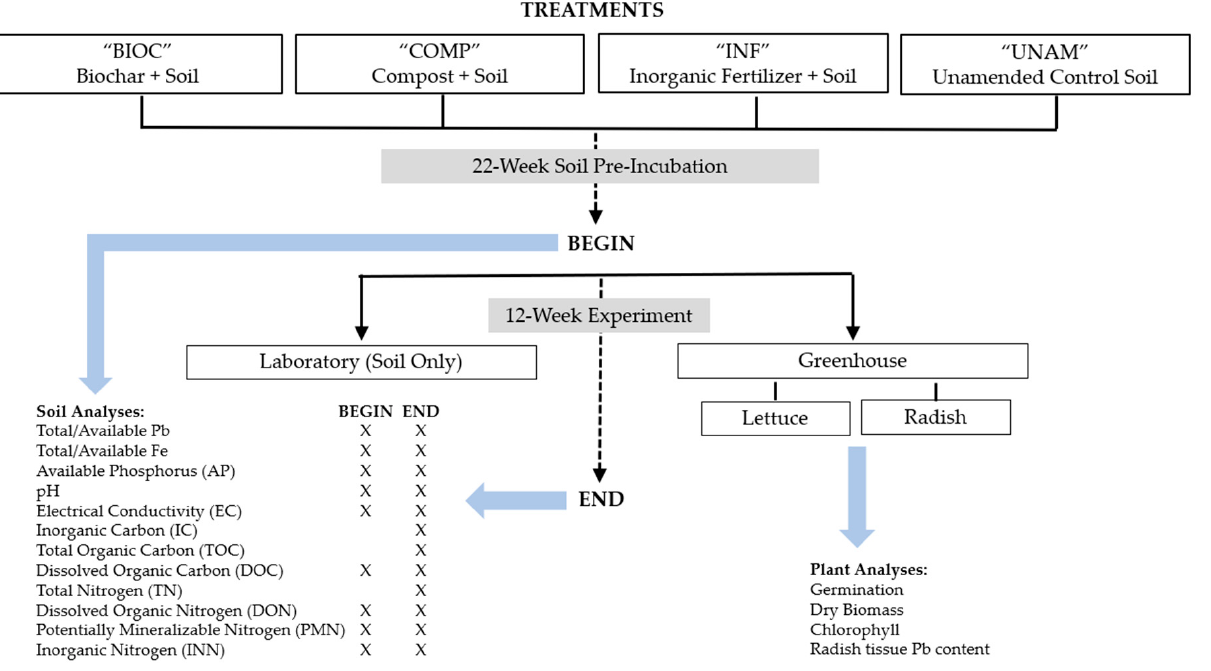
Figure 1. Graphical scheme of study design and analyses conducted.